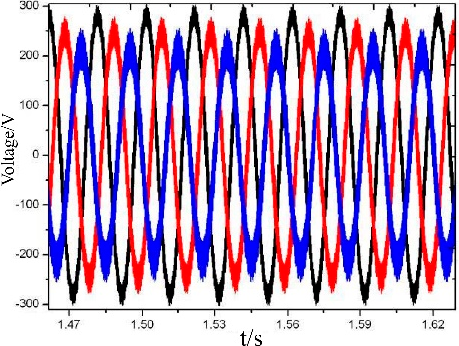
Figure 20. Waveform of 3-phase unbalanced voltage.